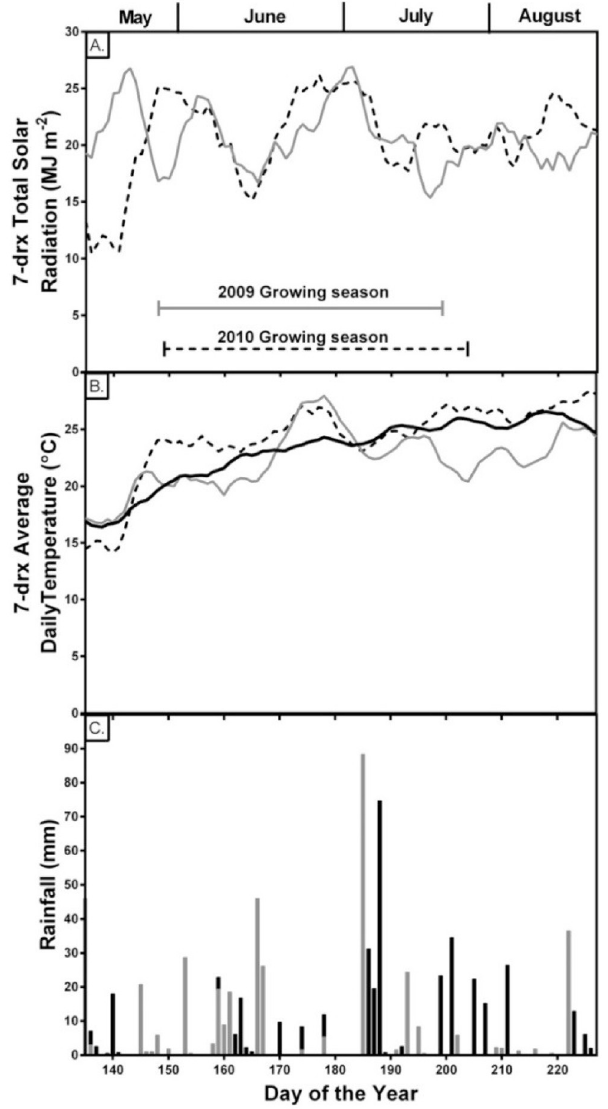
Fig 1. Seven-day running averages versus day of year for solar radiation (A), Average temperature (B), and the daily rainfall (C), during the 2009 and 2010 growing seasons. The solid gray line indicates 2009 and dashed blacked line indicates 2010 growing season. Solid black line indicates the average daily temperature from 2001 to 2010. Solid grey and black bars indicate 2009 and 2010 daily rainfall,